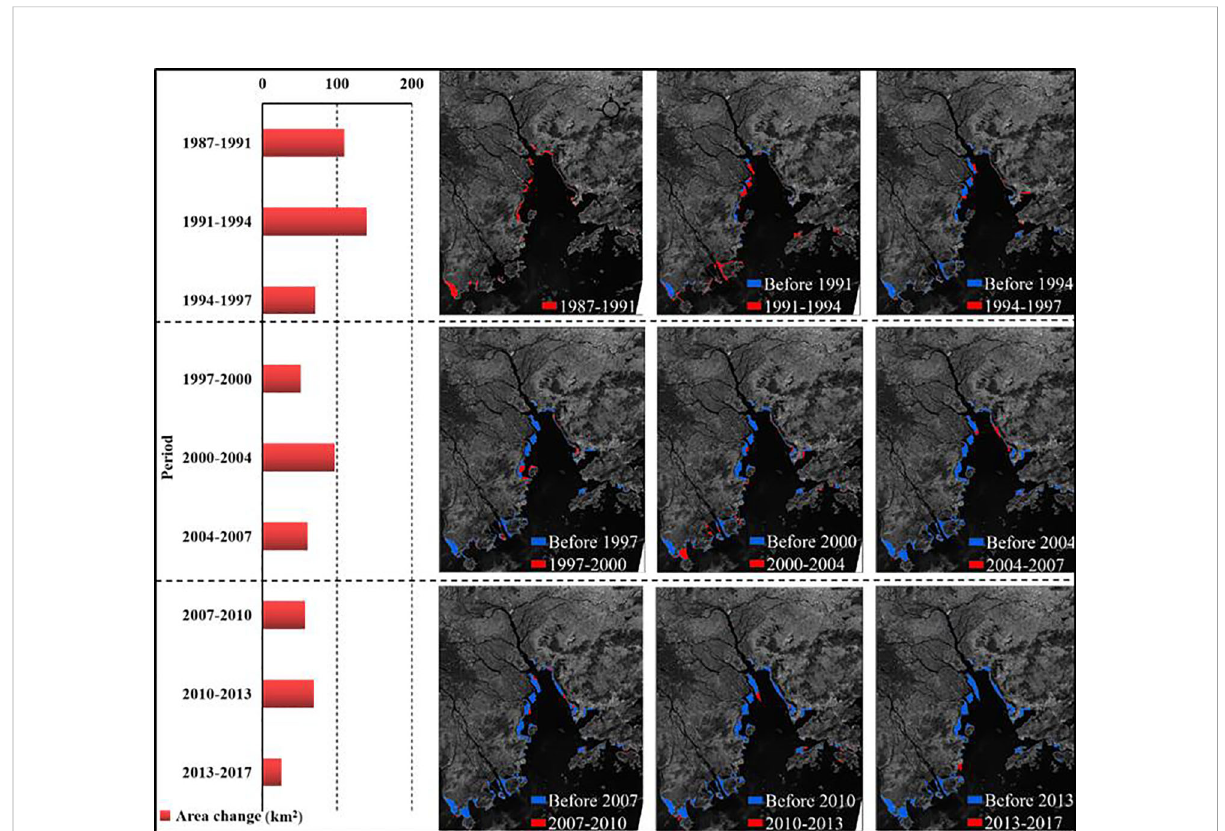
FIGURE 7 The spatiotemporal variations of the land area in the Pearl River Estuary during the period from 1987 to